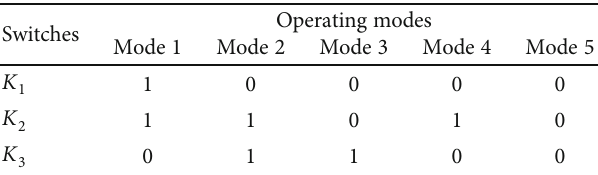
Table 1: Logic states of the relays for the di ff erent modes of operation.